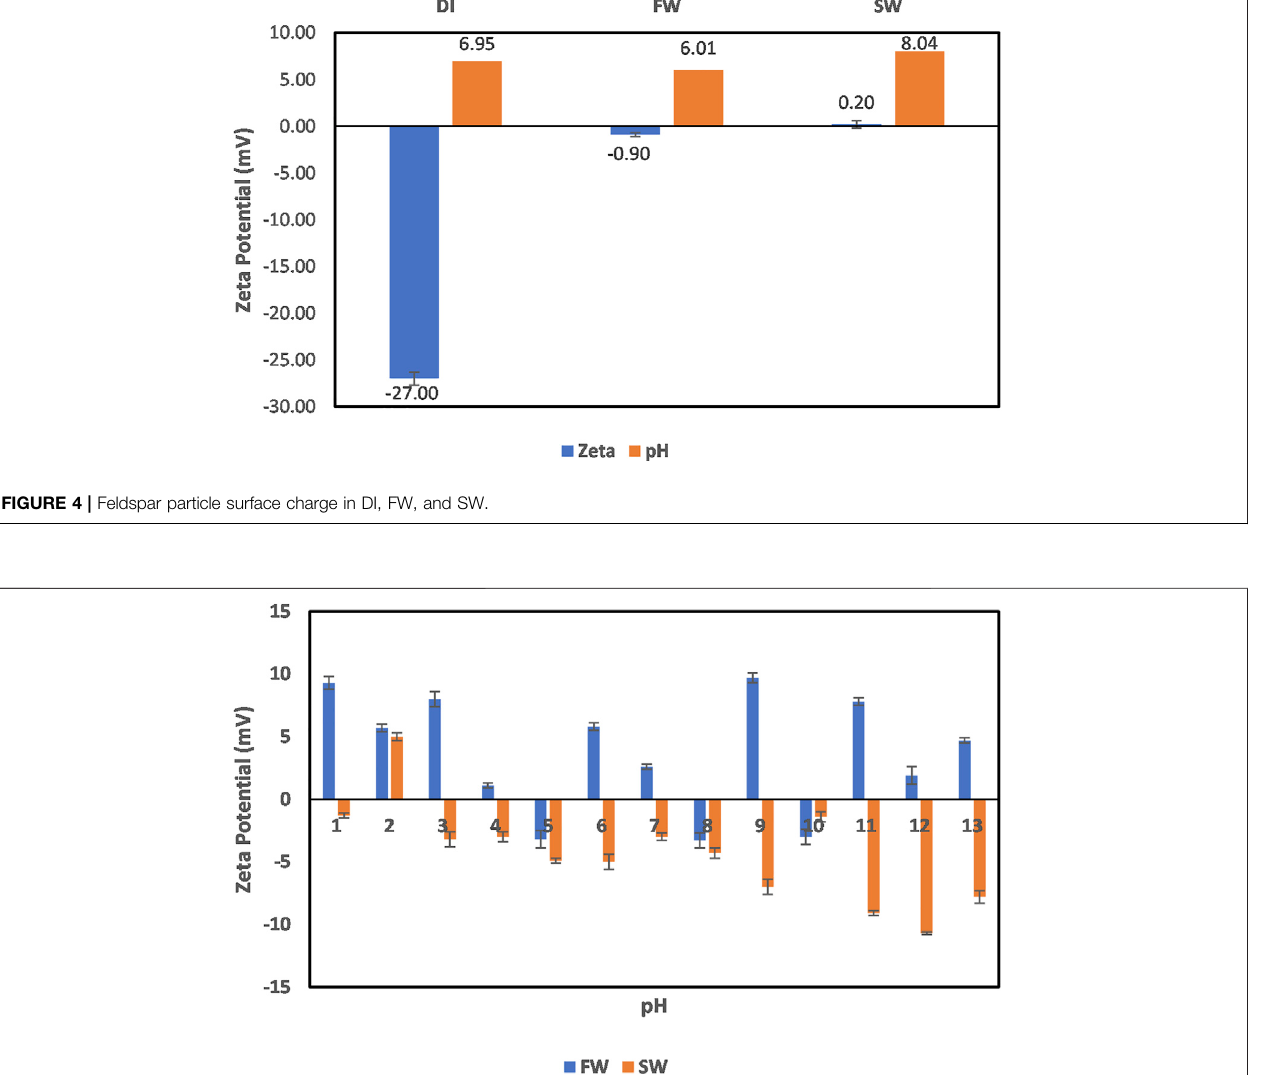
FIGURE 5 | Effect of oil fi eld operation on barite particle surface